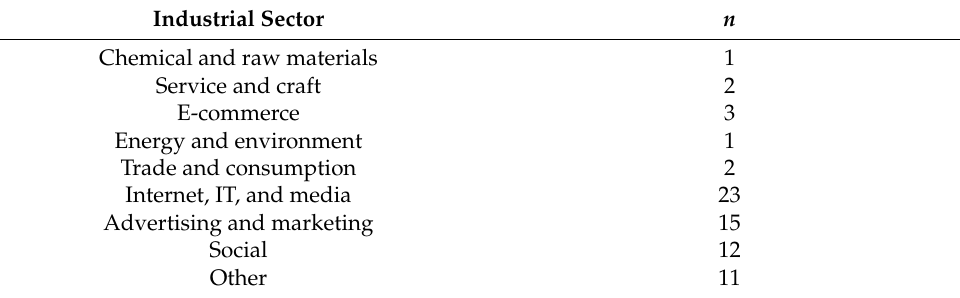
Table 4. Industrial sectors in which the participants